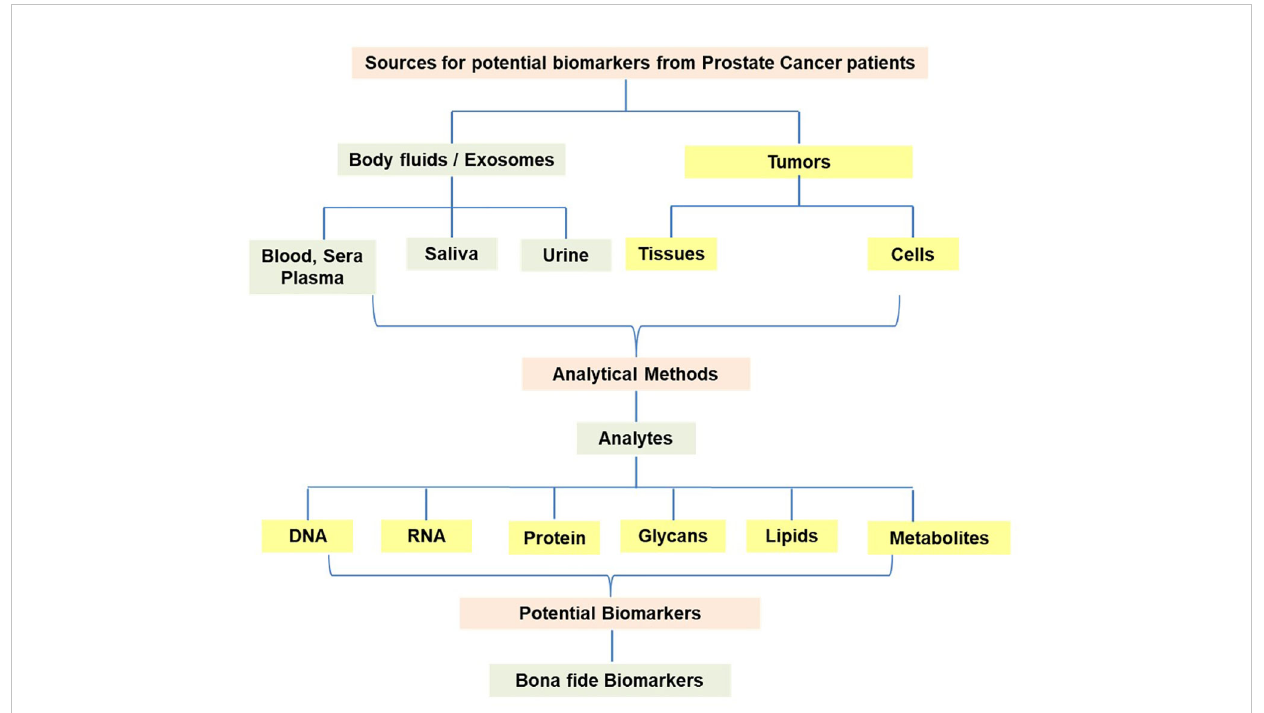
FIGURE 1 Development of novel potential molecular biomarkers from various specimens derived from prostate cancer